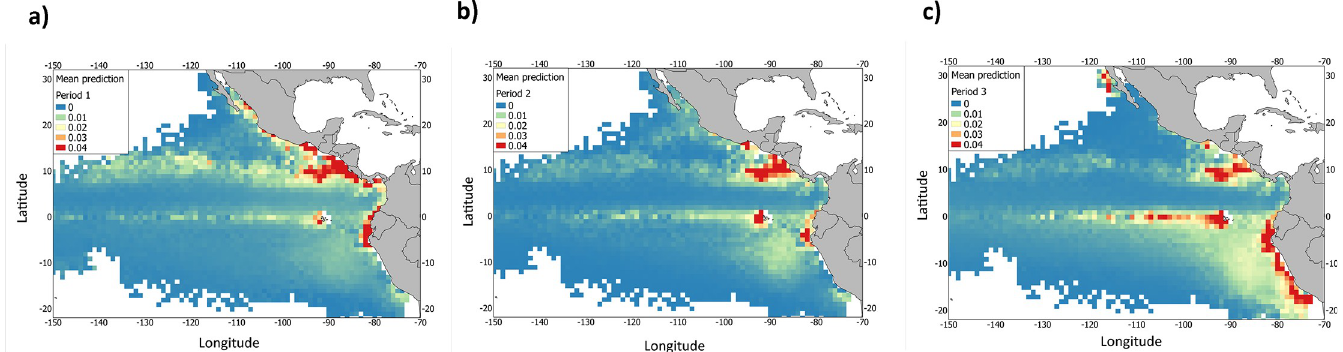
Fig 7. Mean prediction of the presence of Mobula mobular bycatch species from the tropical tuna purse-seine fishery (2005–2015) in the eastern Pacific Ocean in a) Period 1, b) Period 2 and c) Period 3 based on the most parsimonious model fit.